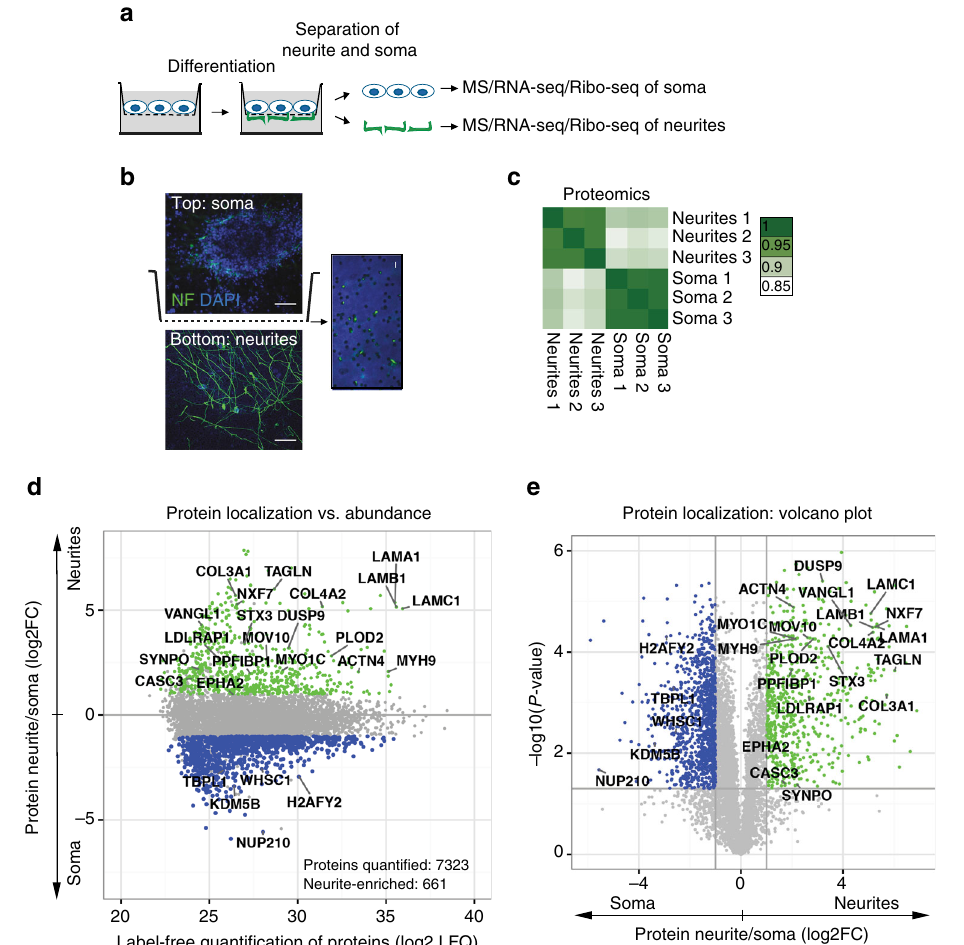
Fig. 1 Local proteome of iNeurons. a Separation scheme. iNeurons are grown on a microporous membrane so that cell outgrowths extend on the lower coated side of the membrane to enable separation of the two cellular compartments (soma and neurites). b Fluorescent micrographs of the iNeurons differentiated on a microporous membrane described in a . Images taken above ( top ) and below ( bottom ) the membrane. Neuro fi lament immunostained neurites ( green ) extend on the lower side of the membrane, whereas soma (DAPI, blue ) remain on the top, scale bar = 50 μ m. The insert shows the magni fi cation of the membrane with neurites growing through the membrane pores ( green ), scale bar = 5 μ m. c Correlation heatmap of mass spectrometry replicates prepared from neurites and soma of iNeurons (three biological replicates in each case). Mass spectrometry samples were quanti fi ed using a label-free quanti fi cation method (LFQ). The numbers represent Pearson correlation coef fi cients of LFQ values. d , e Local proteome from neurites and soma. The data are presented as protein enrichment in neurites versus soma plotted against average LFQ intensities ( left ) and as a volcano plot ( right ). Green : neurite-localized proteins (log2FC > 1, P -values < 0.05); blue : soma-localized proteins (log2FC < − 1, P -values <